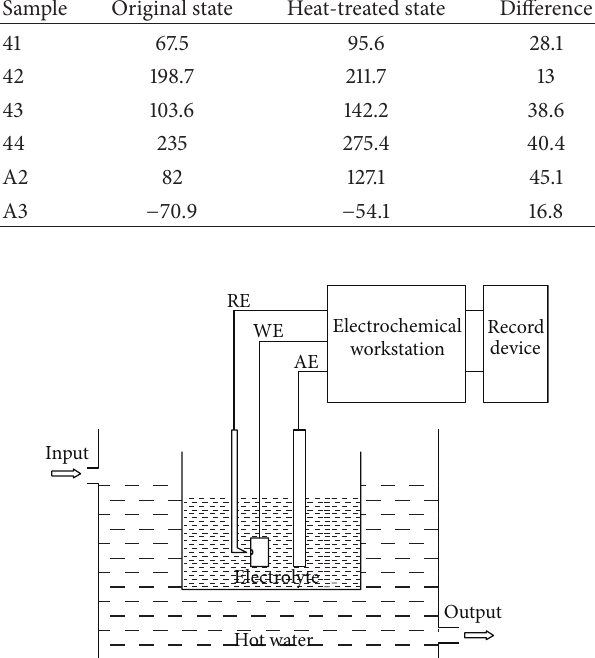
Figure 1: A three-electrode system for measuring the impedance of the